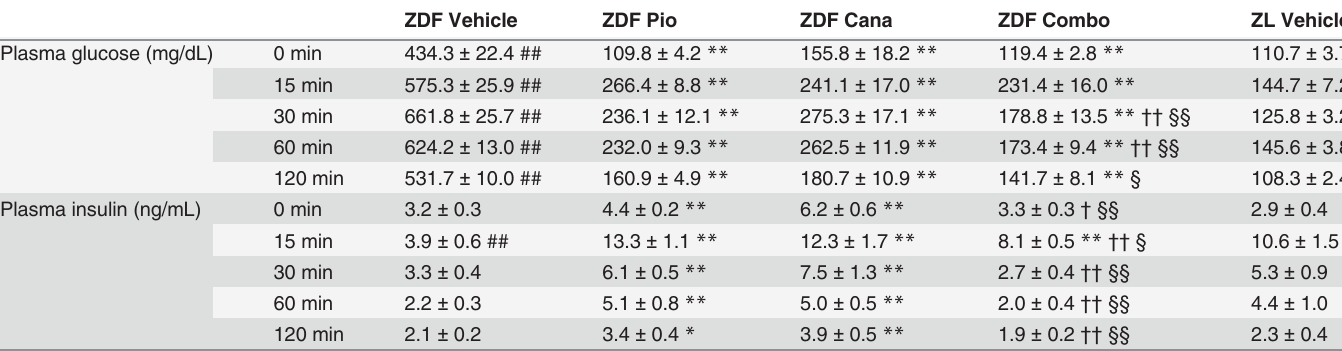
Table 2. Effects of combination therapy on glucose and insulin excursions during OGTT in ZDF and ZL